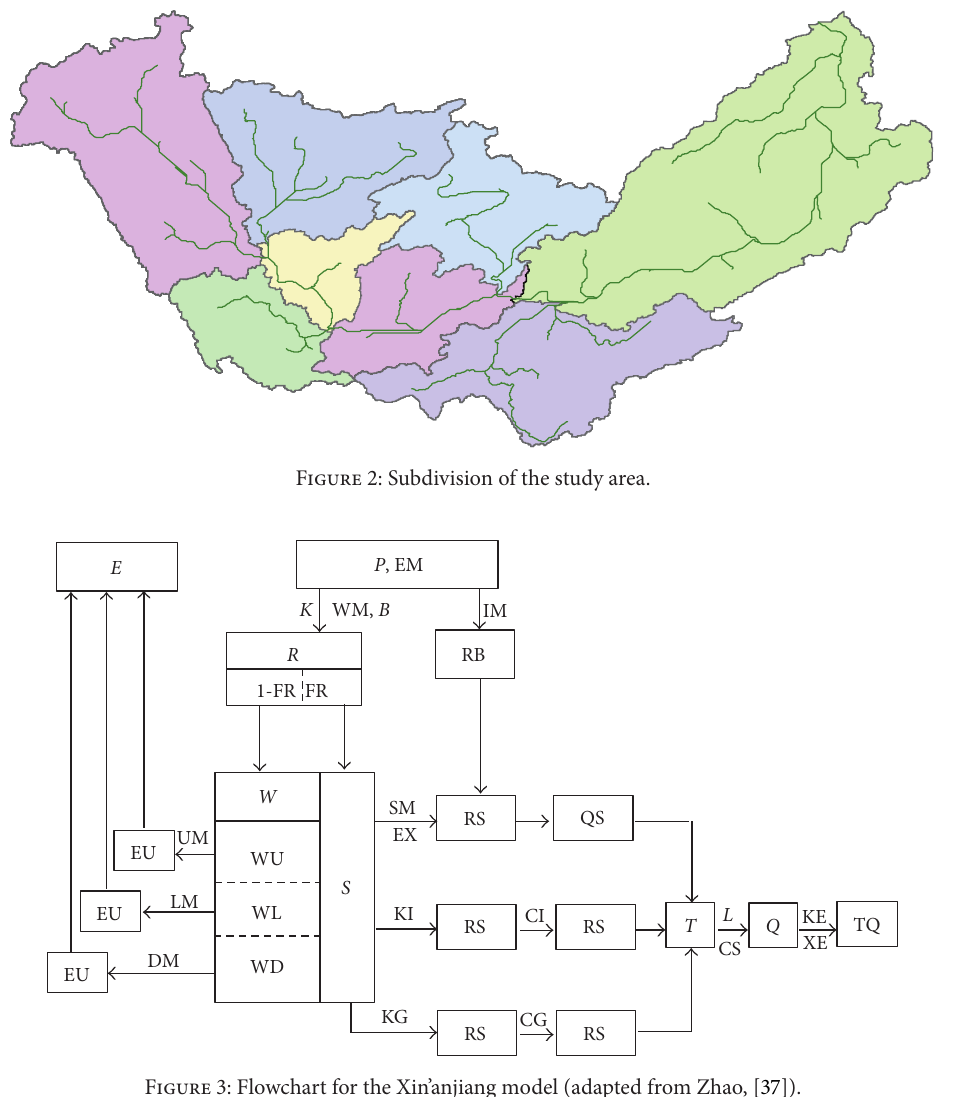
Figure 3: Flowchart for the Xin’anjiang model (adapted from Zhao,